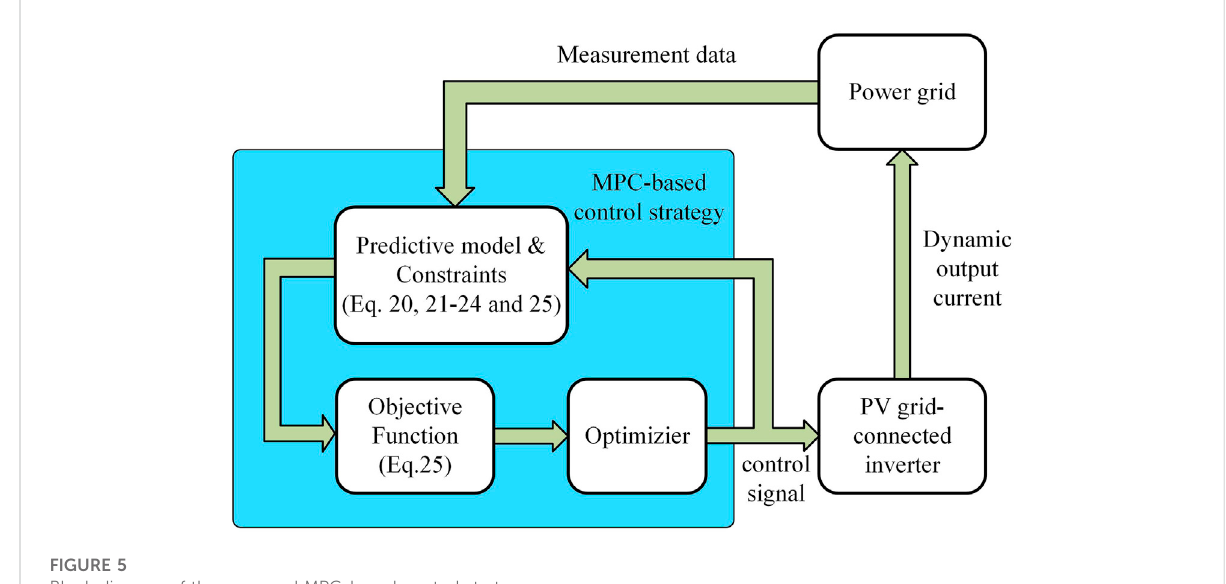
FIGURE 5 Block diagram of the proposed MPC-based control strategy.